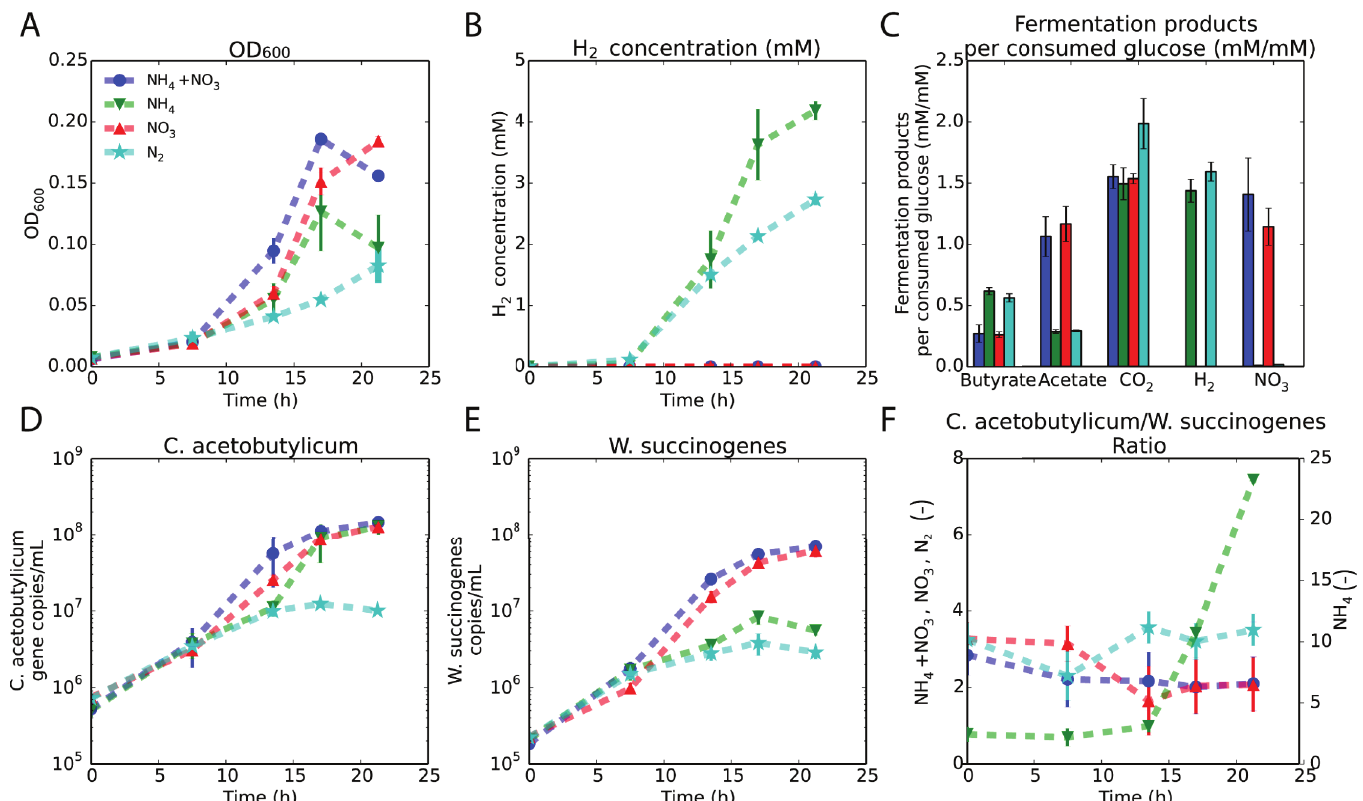
Fig 2. Nitrogen-source alters the phenotypic behaviour of the co-culture in batch experiments. A shows optical density measurements at 600 nm. B is the measuredH 2 concentrations. C are fermentation products per consumedglucoseat the the end of the cultivationperiodand is the sum of the production and consumption of the species in the co-culture. The NO 3- is the amount of NO 3- reduced. D and E are the quantifiedgenecopies concentration per mL of C. acetobutylicum and W. succinogenes . F shows the ratios of C. acetobutylicum and W. succinogenes based on gene-copy number. This is to show that both strains show balancedgrowth duringbatch cultivation.The copy numbers are corrected for the amount of geneson the genome.